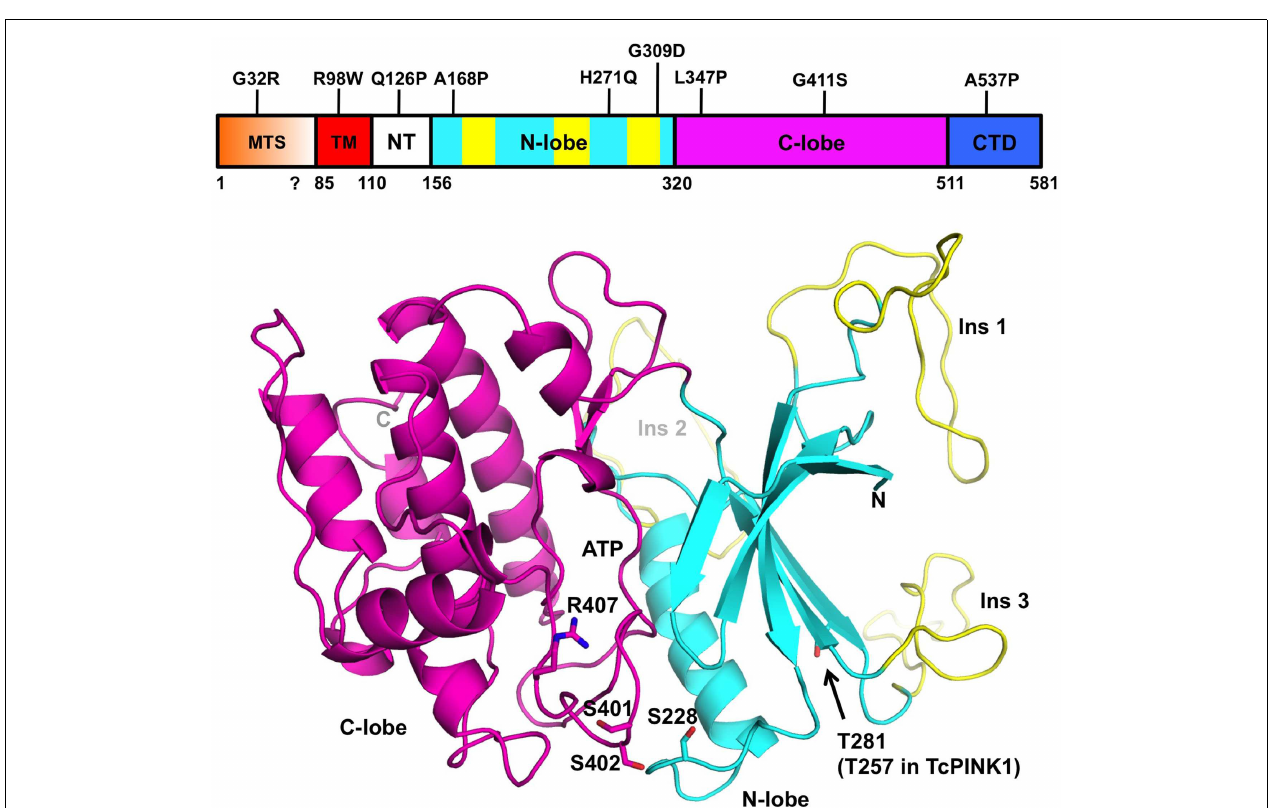
Model DataBase (PM0077187).The N- and C-terminal lobes are colored in cyan and magenta, respectively.The ATP binding site is located in the cleft between the two lobes.The three phosphorylation sites (Ser228, Ser402, Thr281) and activation loop residues (Ser401, Ser402, and Arg407) are shown as sticks.The model does not comprise the N-terminal (112–155) and C-terminal (512–581) regions of the soluble domain, which cannot be modeled by